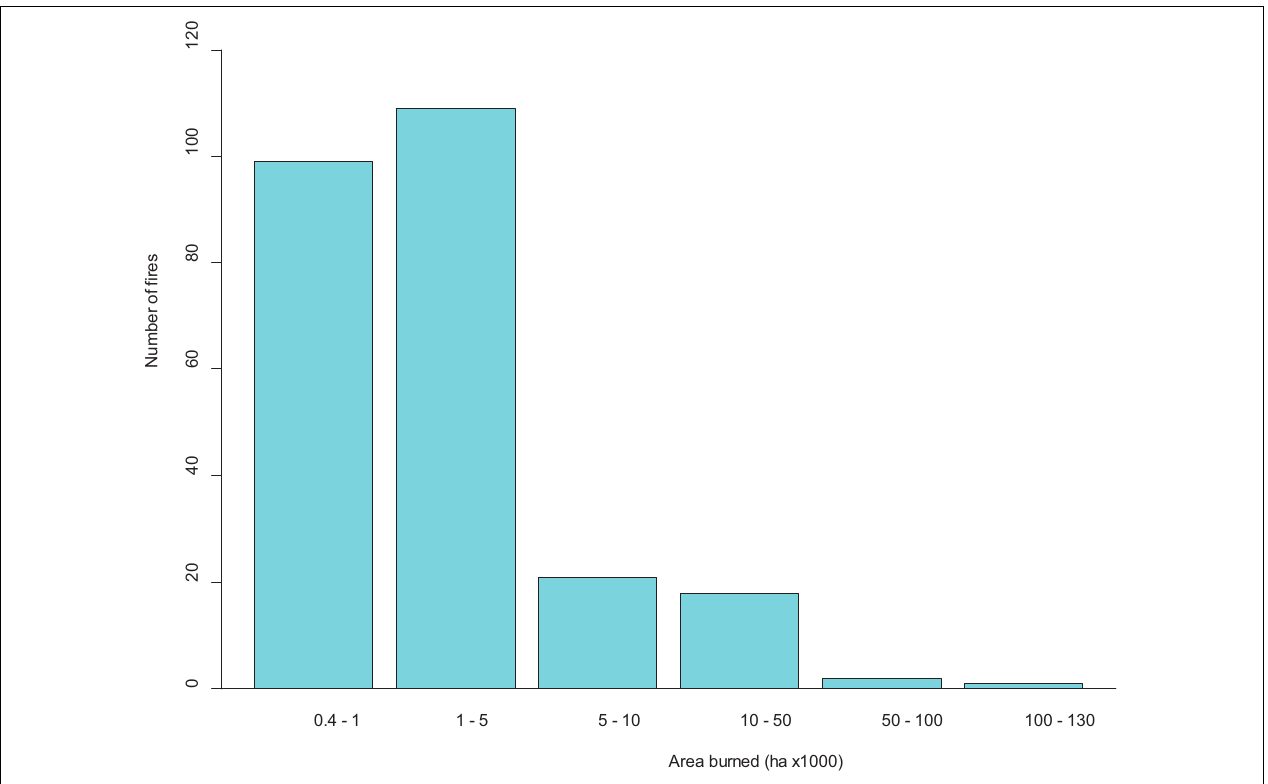
FIGURE 3 | Distribution of the area within the perimeters of 250 wildfires that burned in the Mojave Desert of North America from 1972 through 2010.